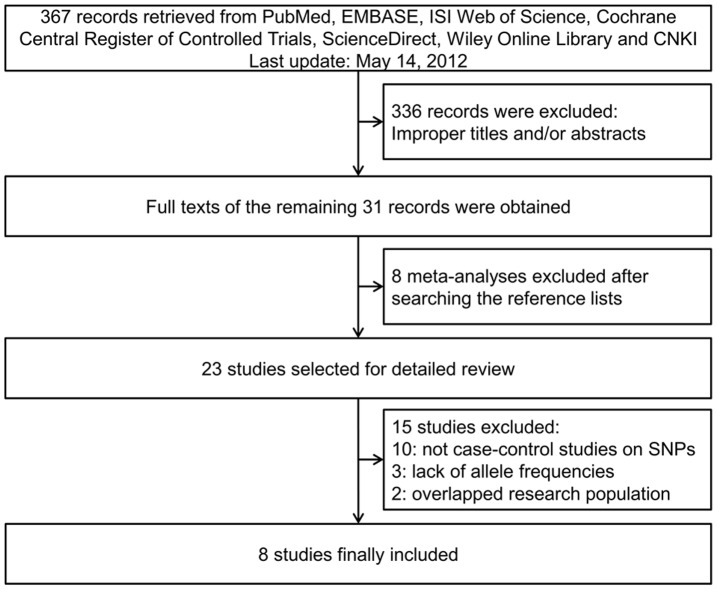
Flow diagram of study identification.